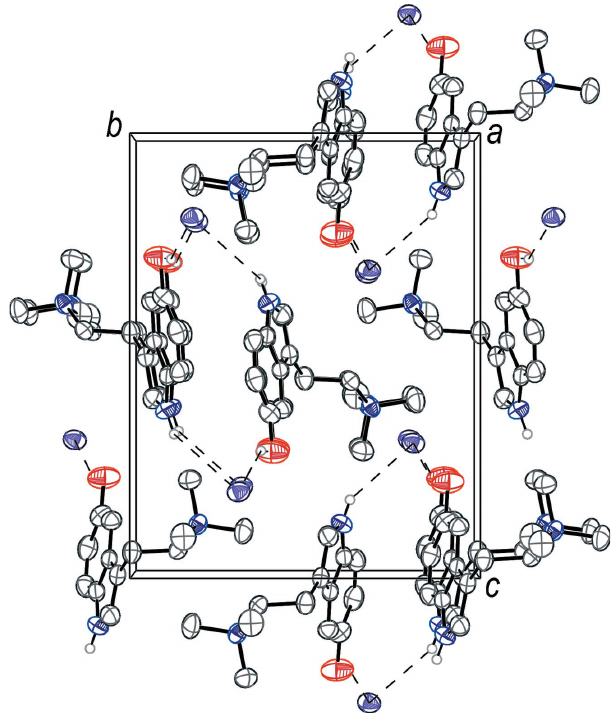
Figure 2 The crystal packing of 5-hydroxy- N , N , N -trimethyltryptammonium (5- HTQ) iodide, viewed along the a axis. The hydrogen bonds (Table 1) are shown as dashed lines. Displacement ellipsoids are drawn at the 50% probability level. Hydrogen atoms not involved in hydrogen bonds are omitted for clarity.